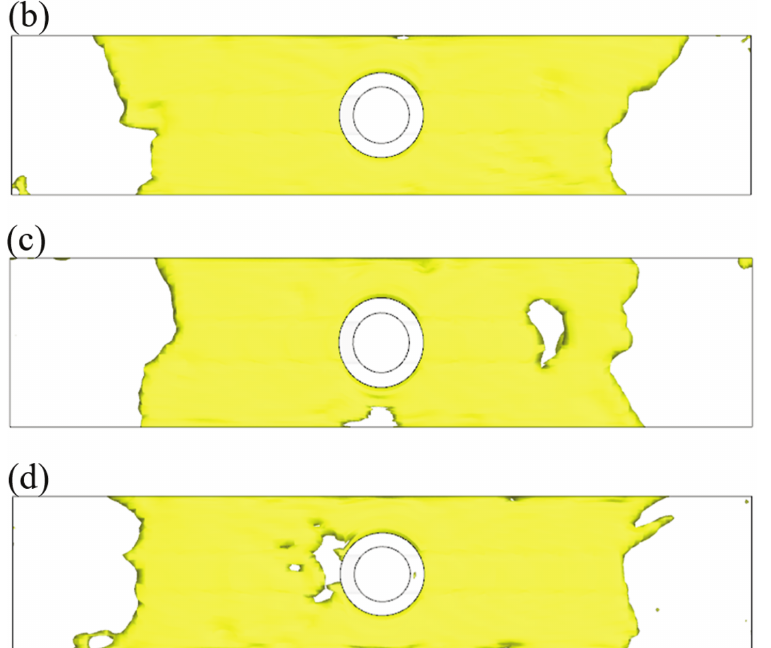
Figure 14: The slag “ eye ” regions in the simula- tion with casting speed of 1.7m/min at different times.